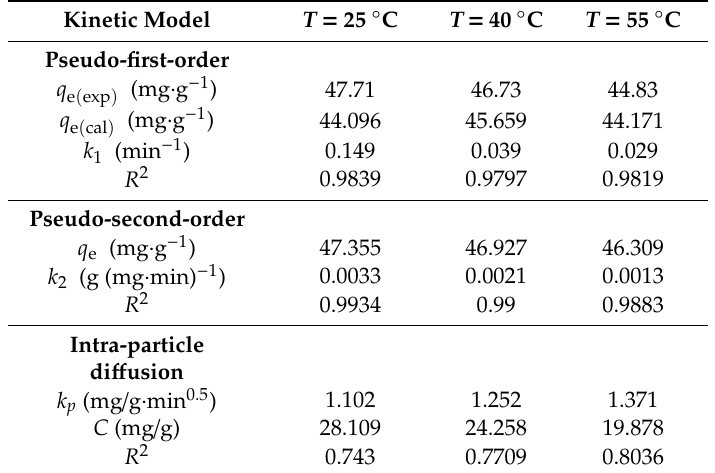
Table 4. Parameters of kinetic models for the adsorption of MO on adsorbent Mn – mica.